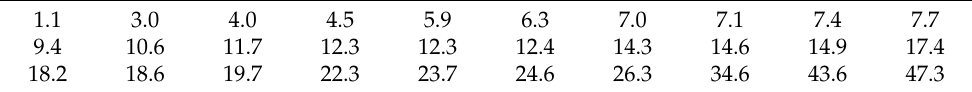
Table 1. Times of repairable mechanical equipment.